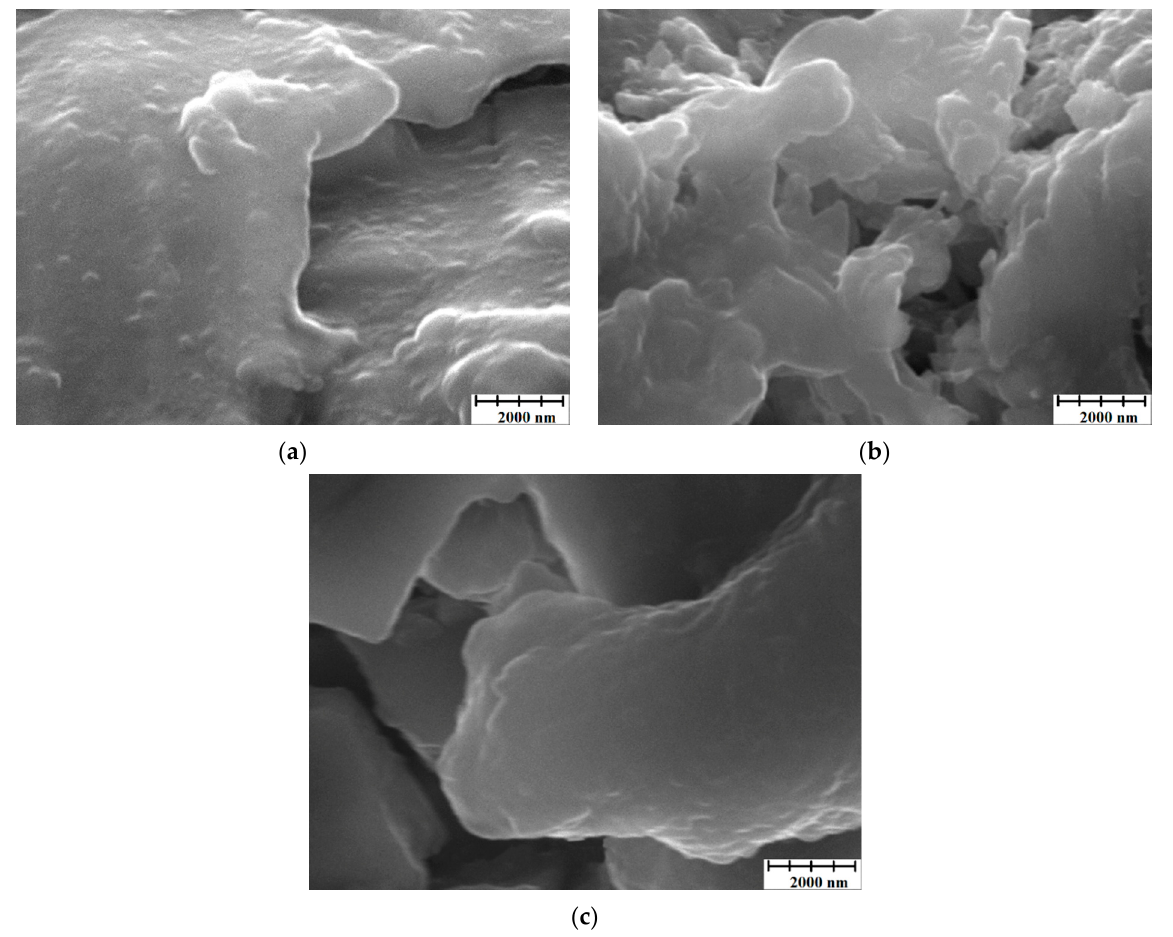
Figure 3. Microphotographs of oxide layer cross-sections: ( a ) sample 02G, ( b ) sample 02H, ( c ) sample 02K.